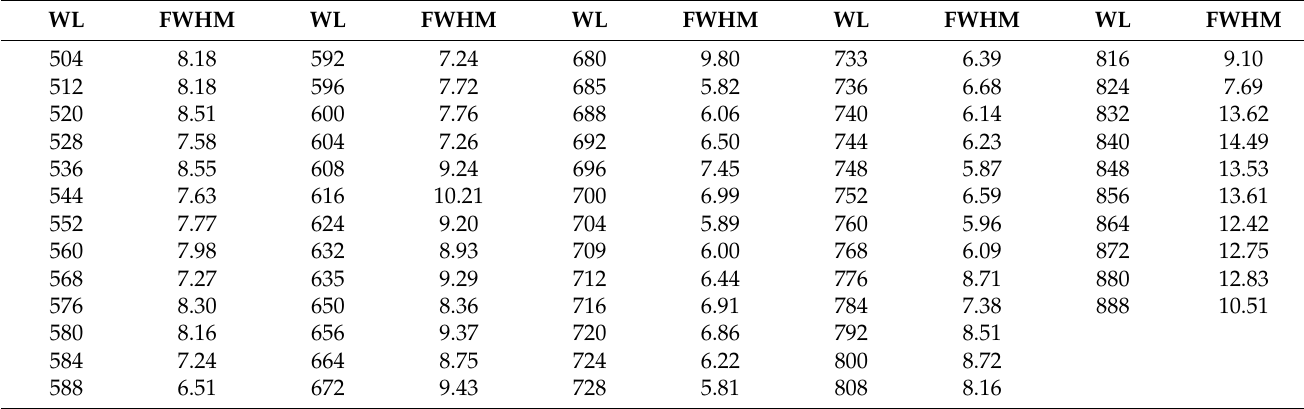
Figure 2. UAV-based hyperspectral platform. Table 1. Wavelength (WL, nm) and full Width at Half Maxima (FWHM, nm) of all the bands of